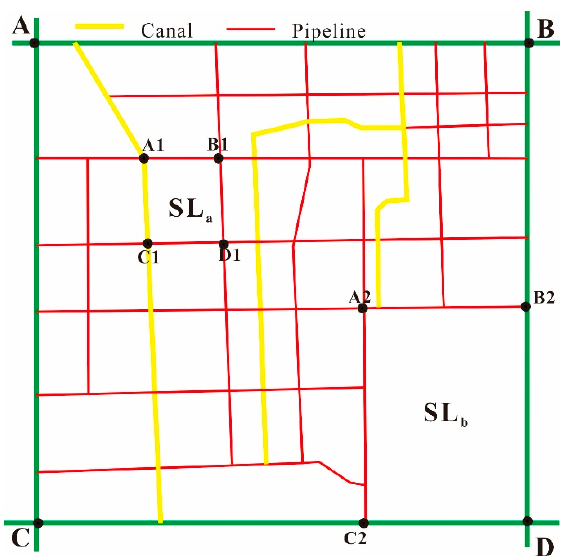
Figure 6. SL (Second-Level) catchment division. The polygon formed by points A, B, C, D denotes the FL catchment, the yellow lines mean the canals, the red lines mean the pipelines. All the lines intersect to form small polygons, which are secondary catchment areas, such as SL a , SL b .